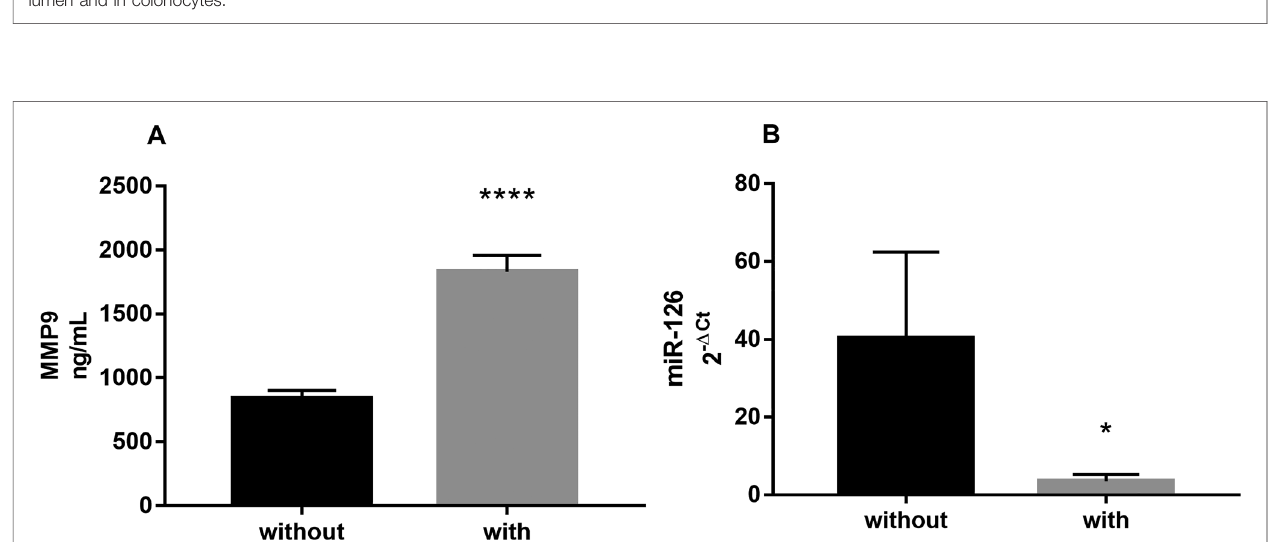
FIGURE 1 | MMP9 protein expression determined by immunohistochemistry with an anti-MMP9 antibody (brown signal). ( A ) Histological section from a Crohn ’ s patient without fi stulas; ( B ) section harvested from a patient with intra-abdominal fi stula. The arrows pointed out the presence of MMP9 staining in the crypt lumen and in colonocytes.